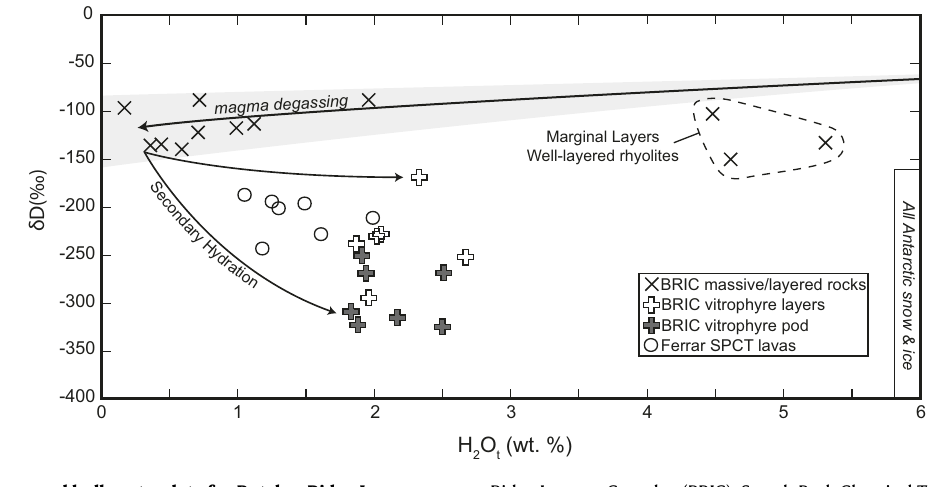
Ridge Igneous Complex (BRIC), Scarab Peak Chemical Type (SPCT) lavas, and Antarctic snow and ice 28,29